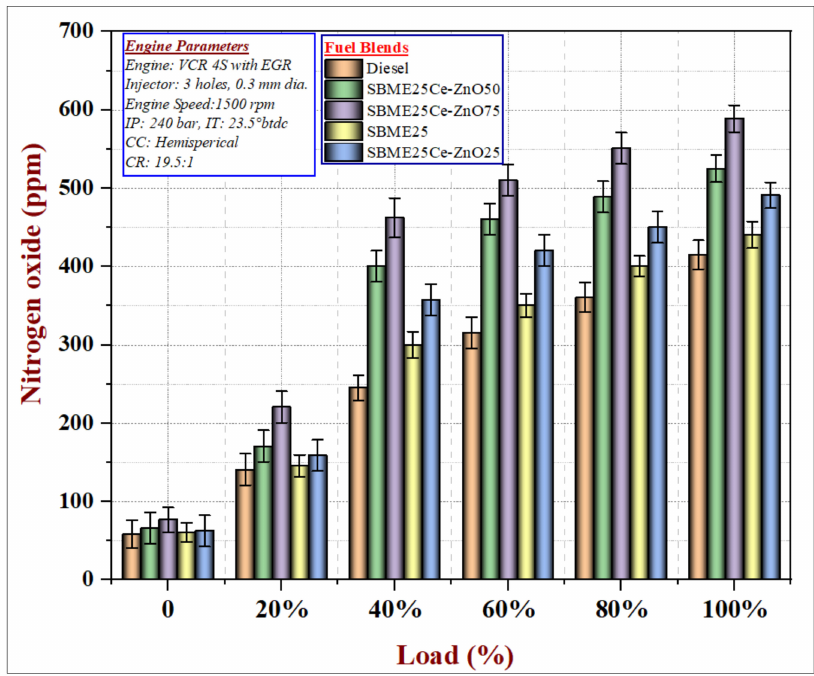
Figure 11. Variation of NOx with load for di ff erent fuel blends.